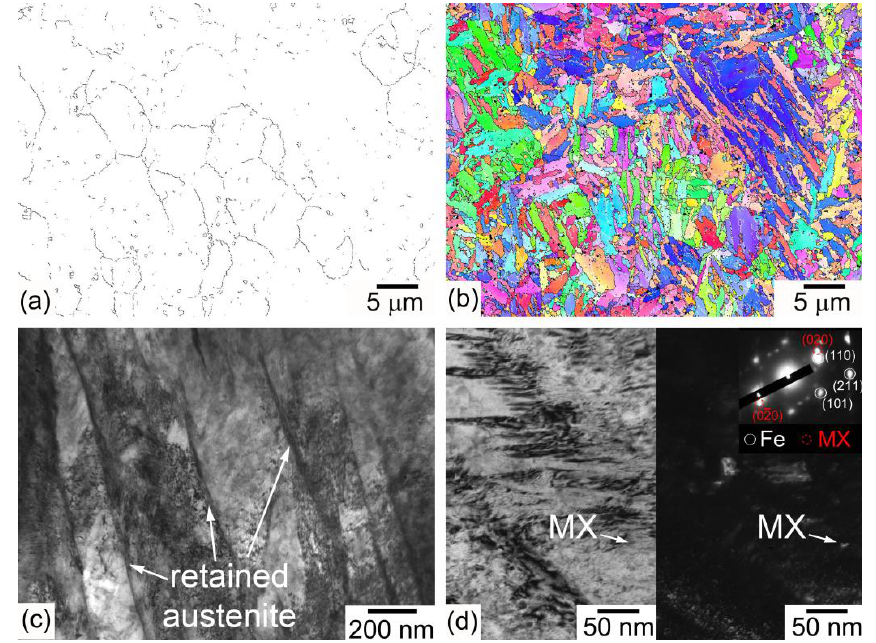
Figure 5. Typical microstructure of the 0.4%C-1.6%Si-1%Cr-0.95%Mo steel with V and Nb after water quenching: the reconstruction of prior austenite grains from an EBSD map ( a ) and EBSD map with martensite packets and blocks. The white and black lines on OIM micrographs mean boundaries with misorientations below and above 15 deg, respectively ( b ). TEM micrograph of martensite lath structure ( c ). TEM micrograph of Nb(C,N) carbonitride within the lath (bright field on the left and dark field on the right side) ( d ).